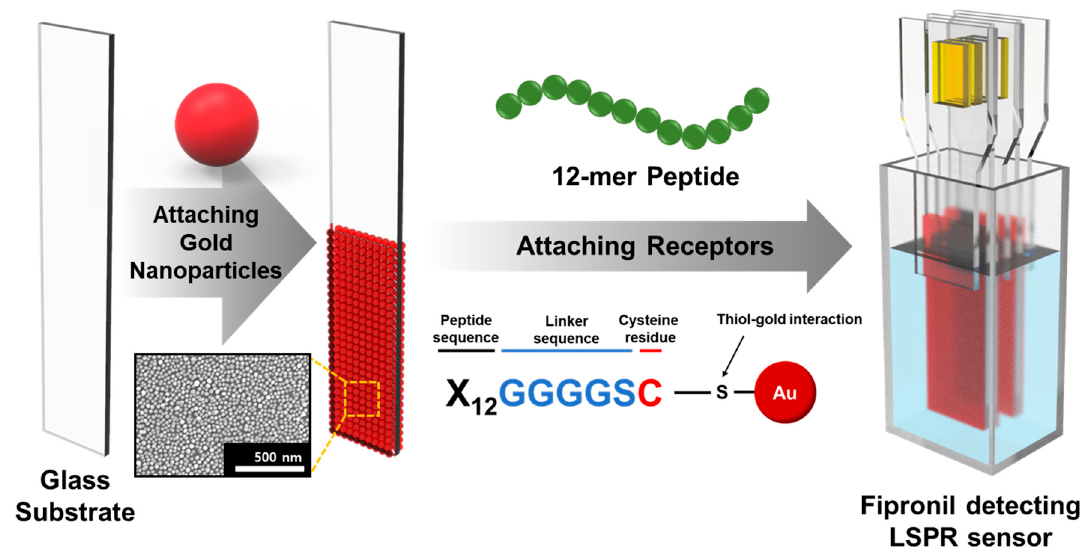
Scheme 1. Schematic illustration of fipronil-specific LSPR sensor chip